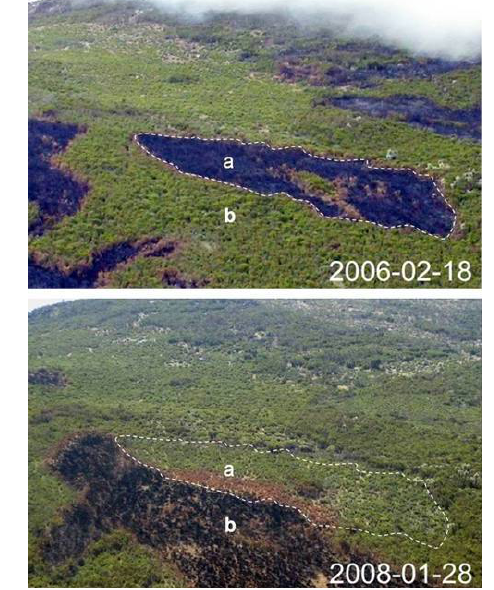
Fig. 2 . Photographs of the same heathland valley side taken nearly two years apart, in the dry period 2006 and 2008. The black areas in the 2006 photo were newly burnt, and the border of one of those (a) has been highlighted with a white trace. The area below (b) was burnt in January 2008, and the fire stopped against the border of the then 2-year-old burn (a), only scorching the plants a few meters into the 2-year- old vegetation, seen as a brown fringe above the 2008 burn. This indicates an upslope wind during the burning, as is typical in the area. Likewise, the left-hand margin of the 2008 fire borders another 2006 burn. The length of the ring- shaped burn (a) is approximately 80